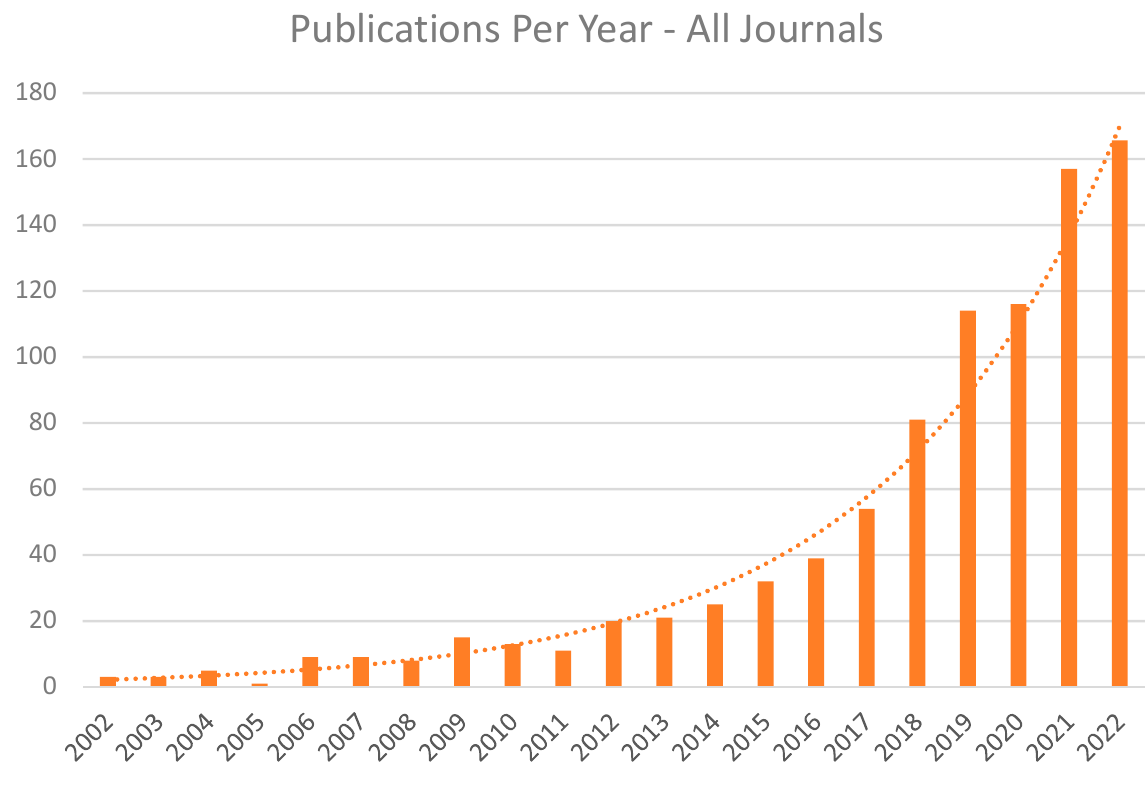
Publication per year, all